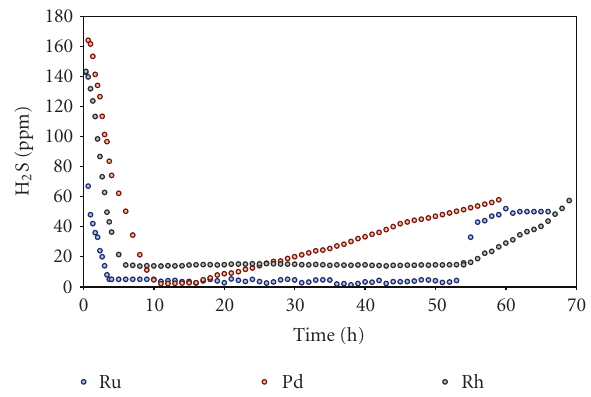
Figure 7: Trend in H 2 S concentration build-up in the exit stream with time on-stream.